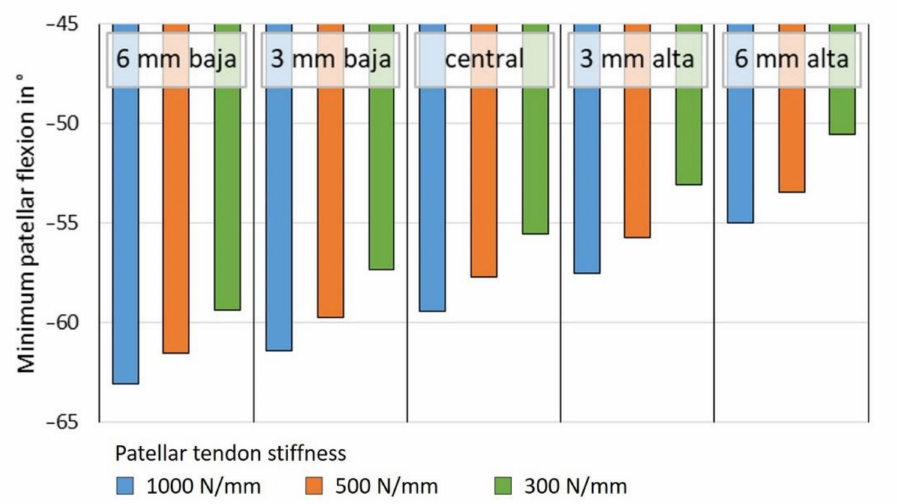
Figure 8. Peak values of the patellar flexion during weight-bearing squat for several initial patellar positions (left to right: 6 mm baja to 6 mm alta) and patellar tendon stiffnesses (blue: 1000 N/mm, orange: 500 N/mm, and green: 300 N/mm). Flexion is given around the femoral flexion axis relative to the femoral implant component. Negative values indicate that the patella flexes less than the femur.